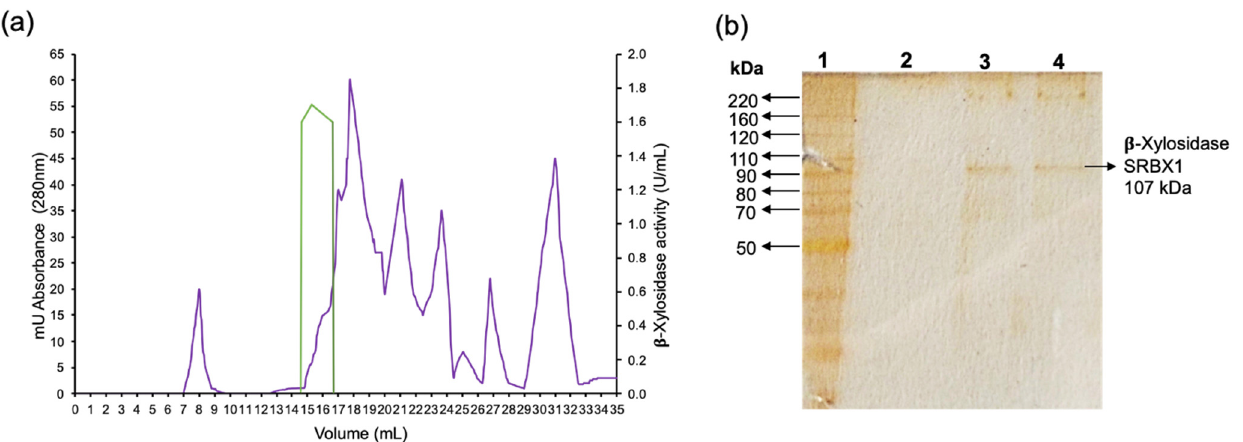
Figure 2. Purification of β -xylosidase SRBX1 from S. reilianum . ( a ) Chromatographic step in the gel filtration column. Green line: enzymatic activity. Purple line: absorbance at 260 nm. ( b ) Silver-stained SDS-PAGE. Line 1: molecular weight marker; line 2: without sample; lines 3 and 4: fractions with activity obtained by gel filtration chromatography. Table 1. Purification of β -xylosidase SRBX1 from S. reilianum .